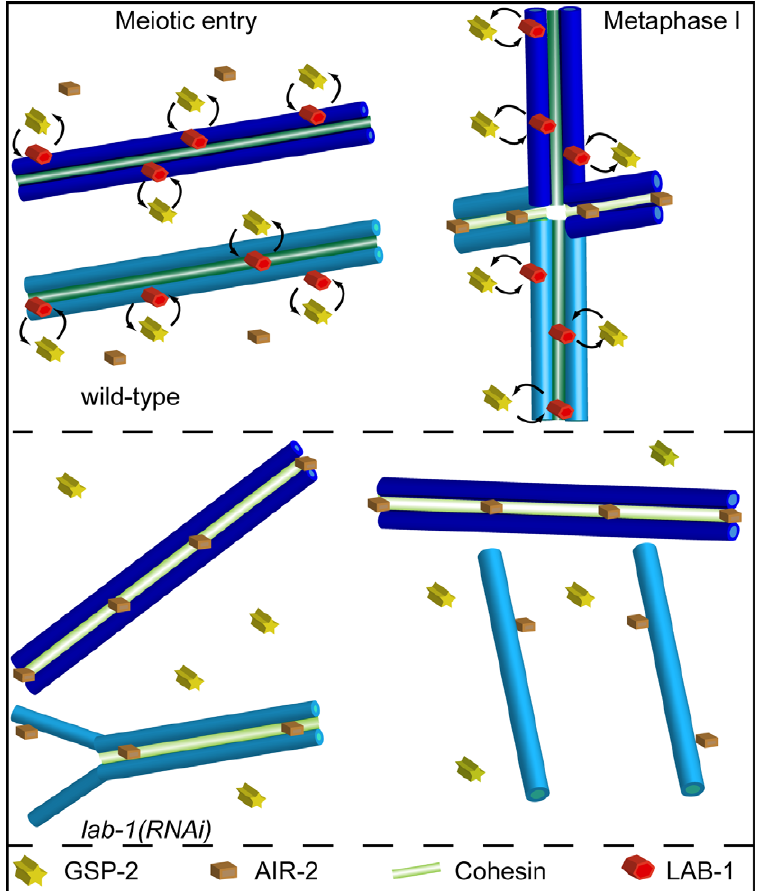
Figure 7. LAB-1 utilizes a similar mechanism to protect SCC during two different meiotic stages. In wild type, LAB-1 starts associating with the chromosomes at the entry into meiosis and transiently targets GSP-2 to the chromosomes. This targeting antagonizes AIR-2 and maintains SCC. During diakinesis, LAB-1 localizes to the long arms, where it specifically antagonizes AIR-2 and protects REC-8 from premature removal. When lab-1 is depleted, AIR-2 associates with the chromosomes as early as transition zone, and SCC is perturbed. The weakened SCC prevents successful binding of homologs and many reach diakinesis as either univalents or detached chromatids.